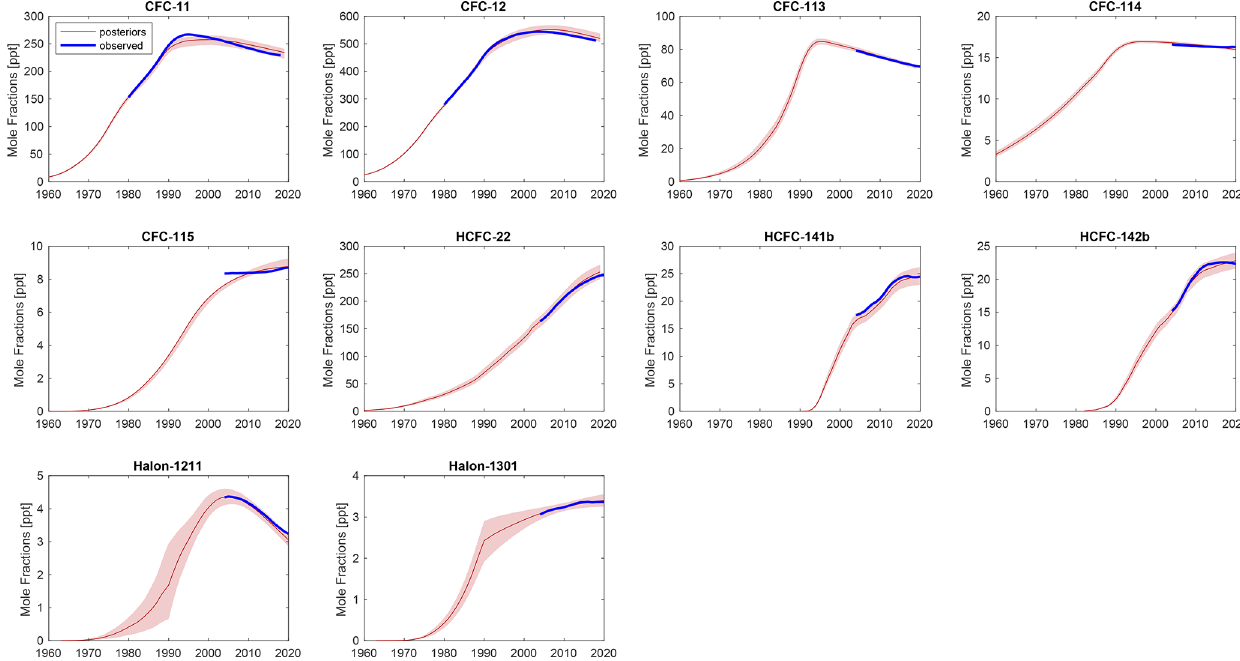
Figure 1. Modeled mole fractions versus observed mole fractions. Red lines indicate the posterior median mole fraction estimate from the Bayesian parameter estimation (BPE), with shaded regions indicating the 90% confidence interval. Blue lines indicate globally averaged observed mole fractions.